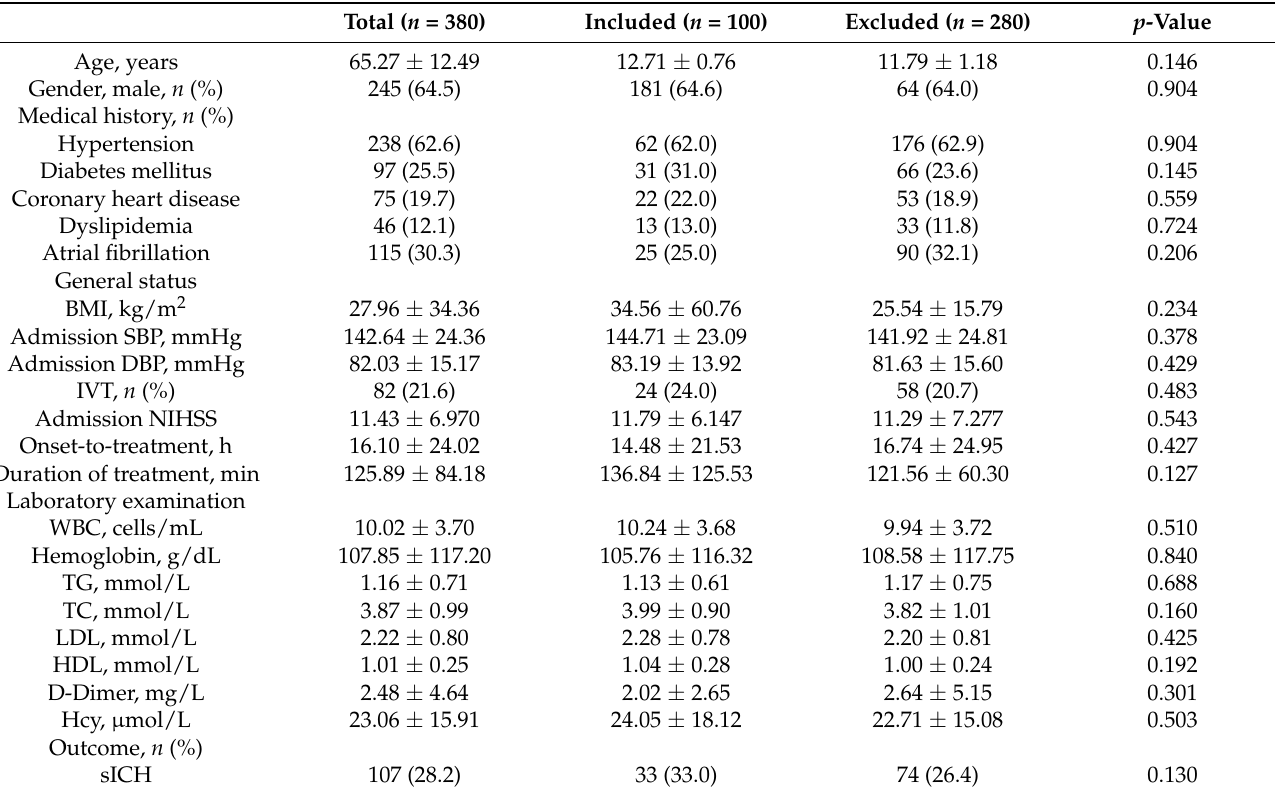
Table 1. Baseline characteristics of the included versus excluded